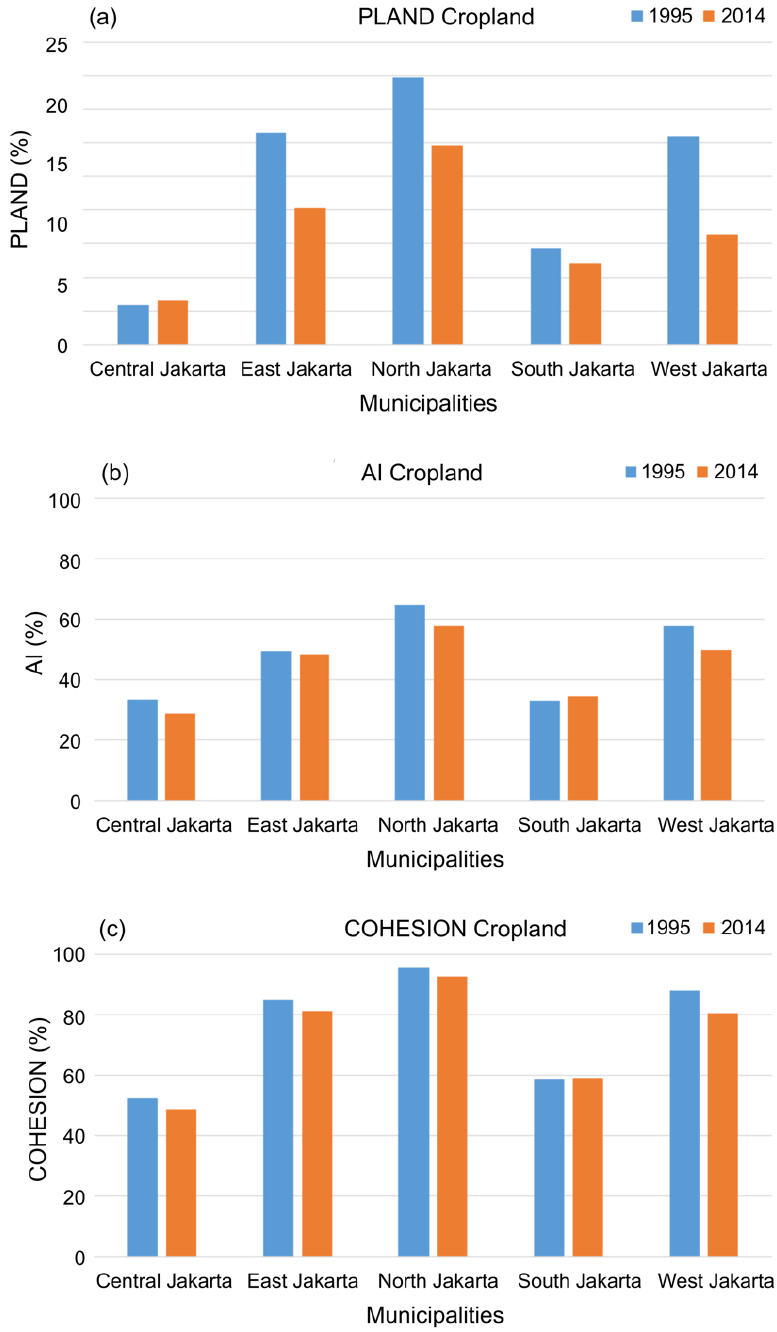
Figure 8. Landscape metrics of cropland. ( a ) Land proportion; ( b ) aggregation index; ( c ) cohesion. In contrast with the landscape patterns of green spaces, urbanization did not have a significant impact on the landscape patterns of bodies of water, as depicted in Figure 9. The proportion of bodies of water in 2014 was similar to that in 1995. The dynamic changes of the landscape patterns of bodies of water were marked by a small increase in the proportion of bodies of water in East Jakarta and South Jakarta, while this proportion decreased in North Jakarta and West Jakarta. However, the aggregation and the connectivity of bodies of water increased in all municipalities in 2014, as shown in Figure